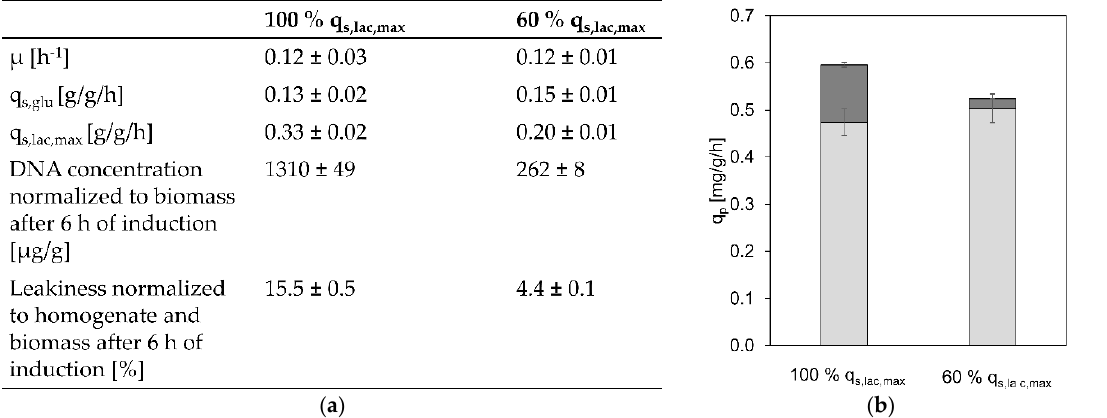
Figure 4. Physiology, leakiness, lysis and productivity at 100% and 60% q s,lac,max ( a ) Comparison of physiological data as well as leakiness and lysis of a cultivation at a q s,glu 0.14 g/g/h and different q s,lac (100% q s,lac,max and 60% q s,lac,max ); ( b ) specific overall, intracellular (light grey), and extracellular (dark grey) product formation rates of cultivations at 100% q s,lac,max and 60% q s,lac,max .